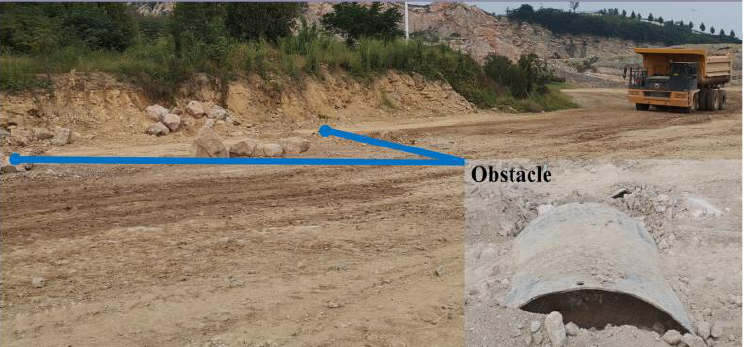
Figure 11. Test road for the mining truck.